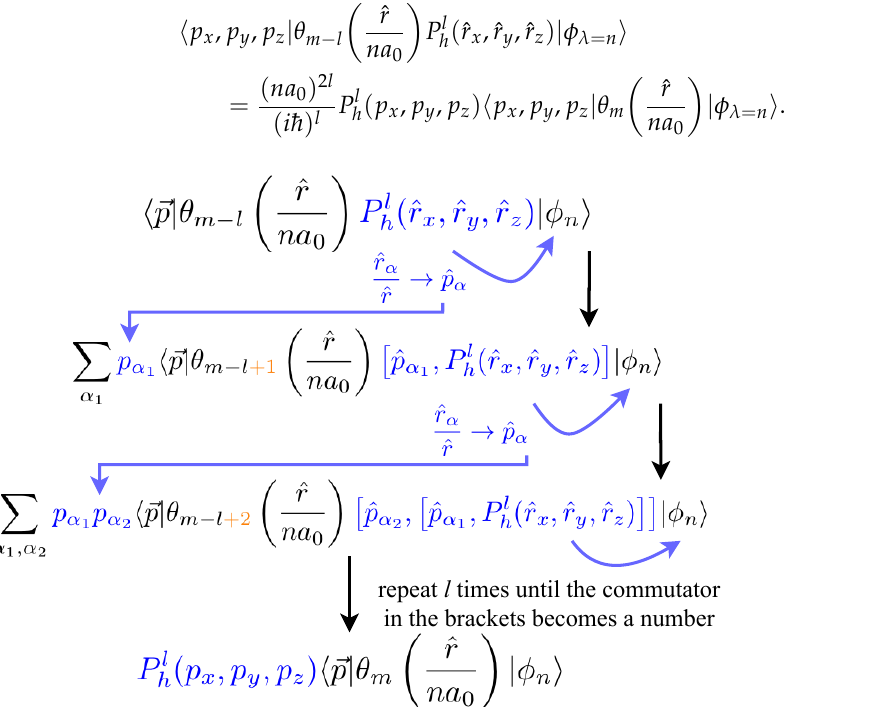
Figure 3. Schematic for how to remove the harmonic polynomial from the operator matrix element to determine the wavefunction in momentum space. Here, θ is a reverse Bessel polynomial and P l a harmonic